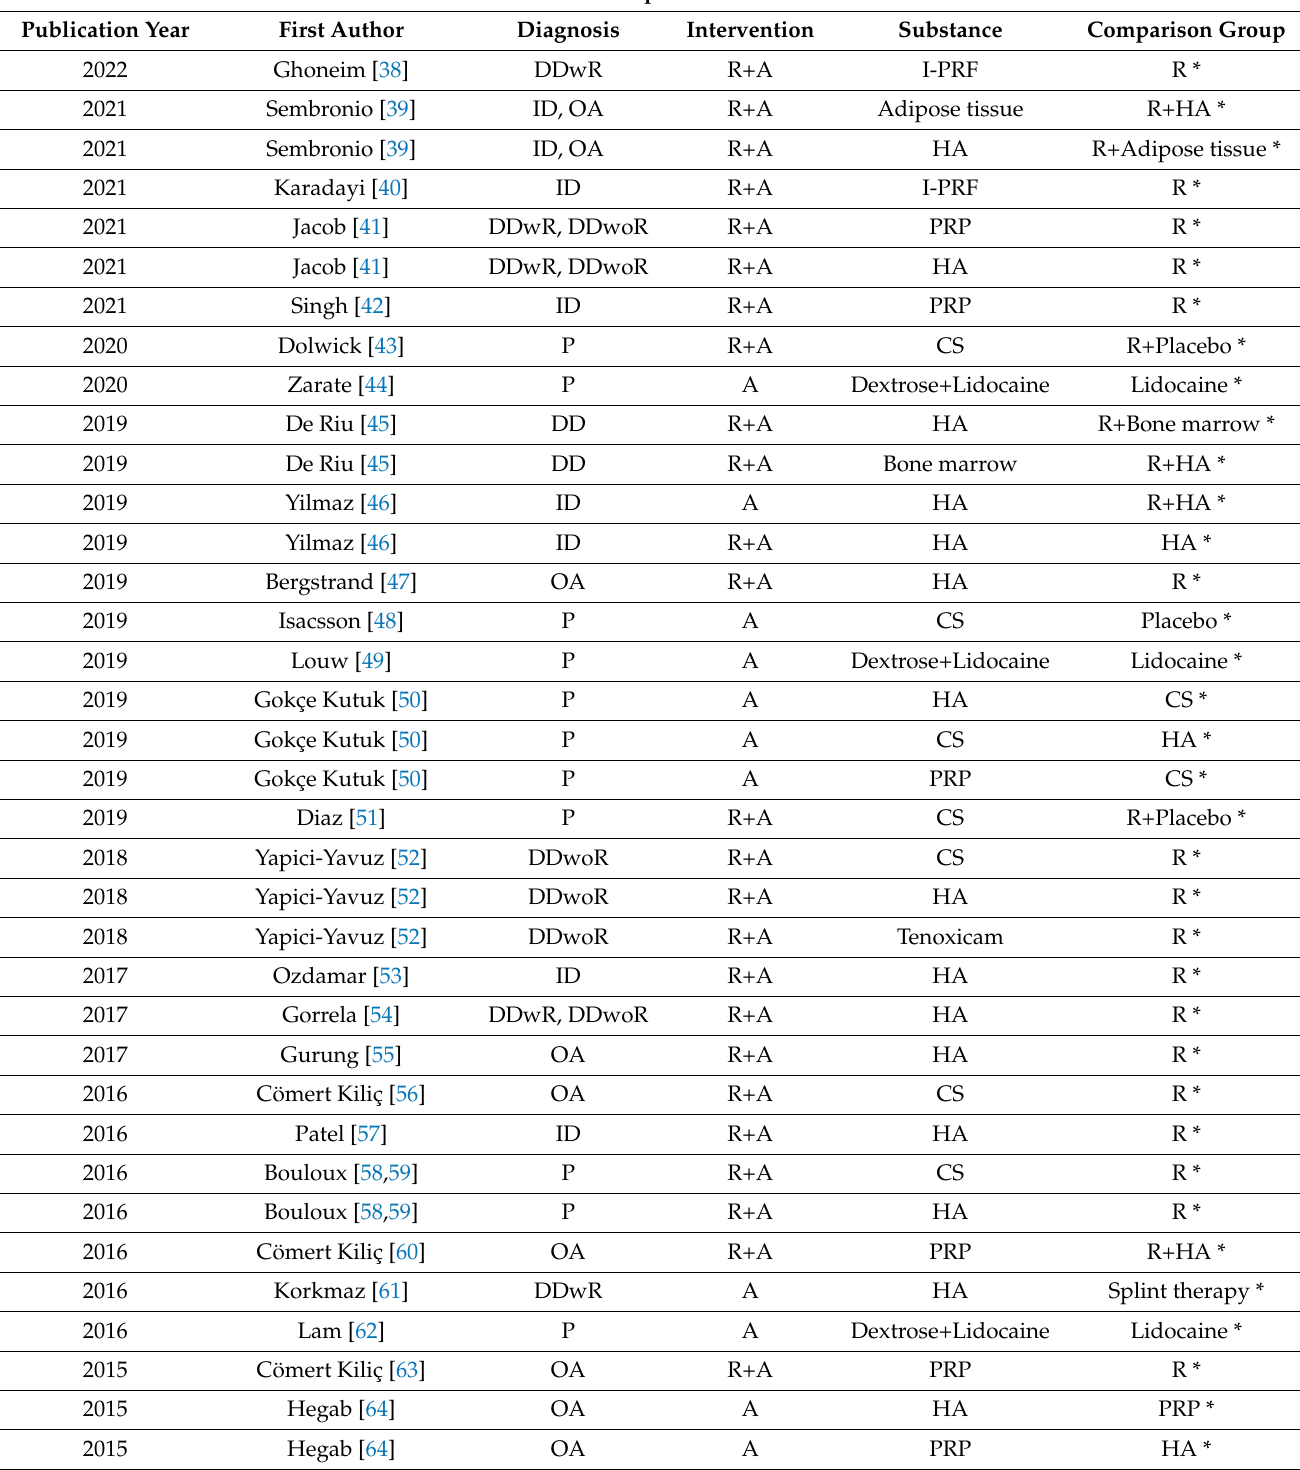
Table 3. Results. ID—internal derangement [34,35]; P—TMJ pain according to ICOP [34,36]; OA— osteoarthritis [34,37]; DDwR—disk displacement with reduction [34,37]; DDworR—disk displace- ment without reduction [34,37]; DD—degenerative disorders [34,37]; R—rinse; A—administration; HA—hyaluronic acid; CS—corticosteroids; PRP—platelet rich plasma; I-PRF—injectable platelet rich fibrin; PRGF—plasma rich in growth factors *—randomized controlled